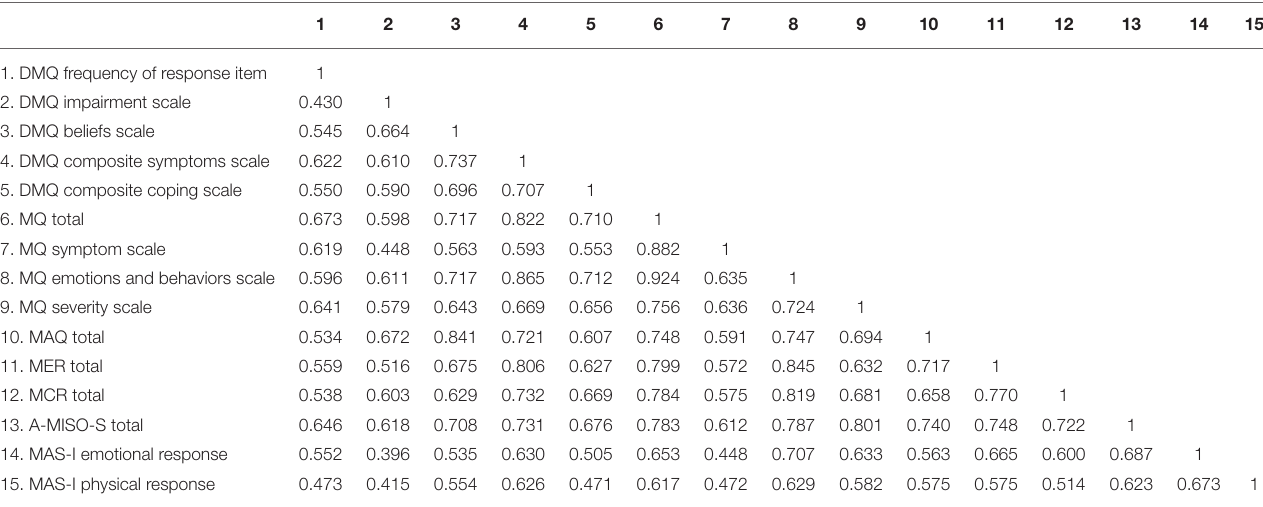
TABLE 5 | Correlations between Duke Misophonia Questionnaire and Existing Measures of Misophonia.